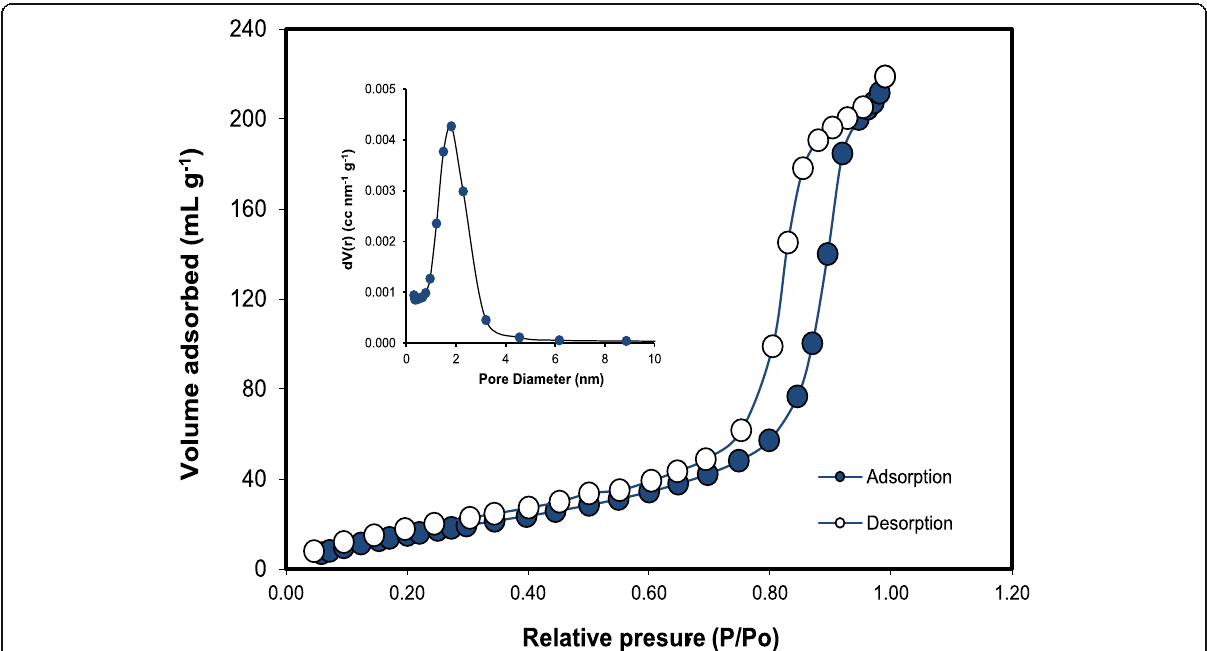
Fig. 3 The nitrogen adsorption-desorption isotherms and pore size distribution of ASS adsorbent